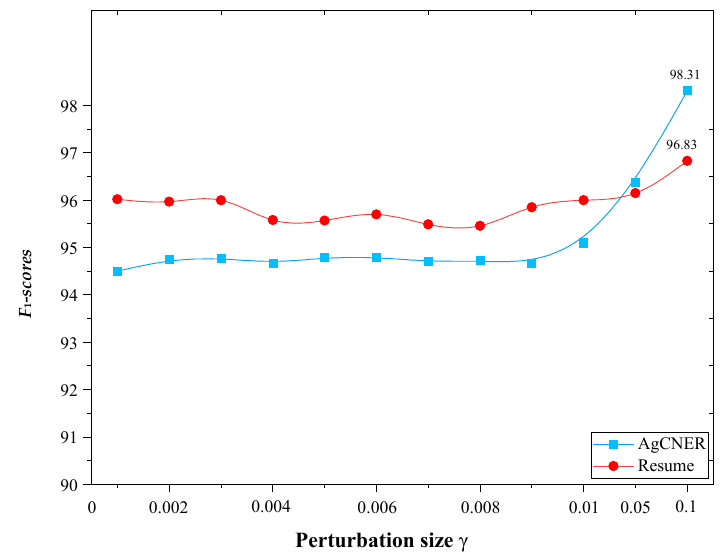
Figure 9. Results by different perturbation sizes γ